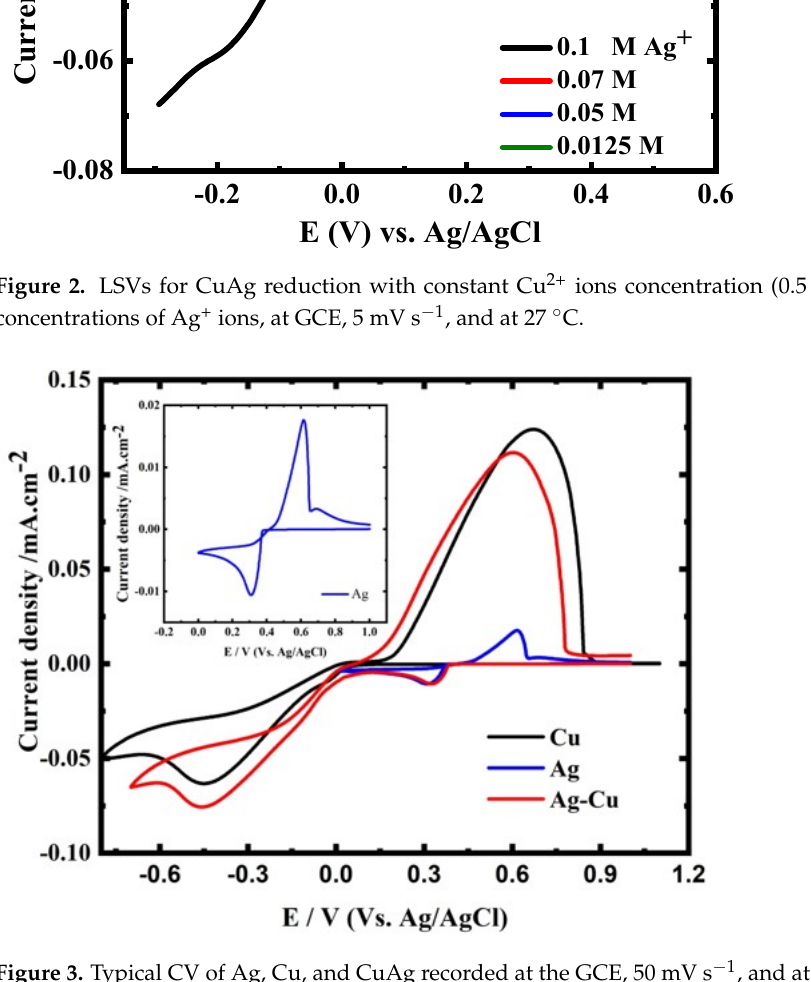
Figure 3. Typical CV of Ag, Cu, and CuAg recorded at the GCE, 50 mV s − 1 , and at 27 °C.